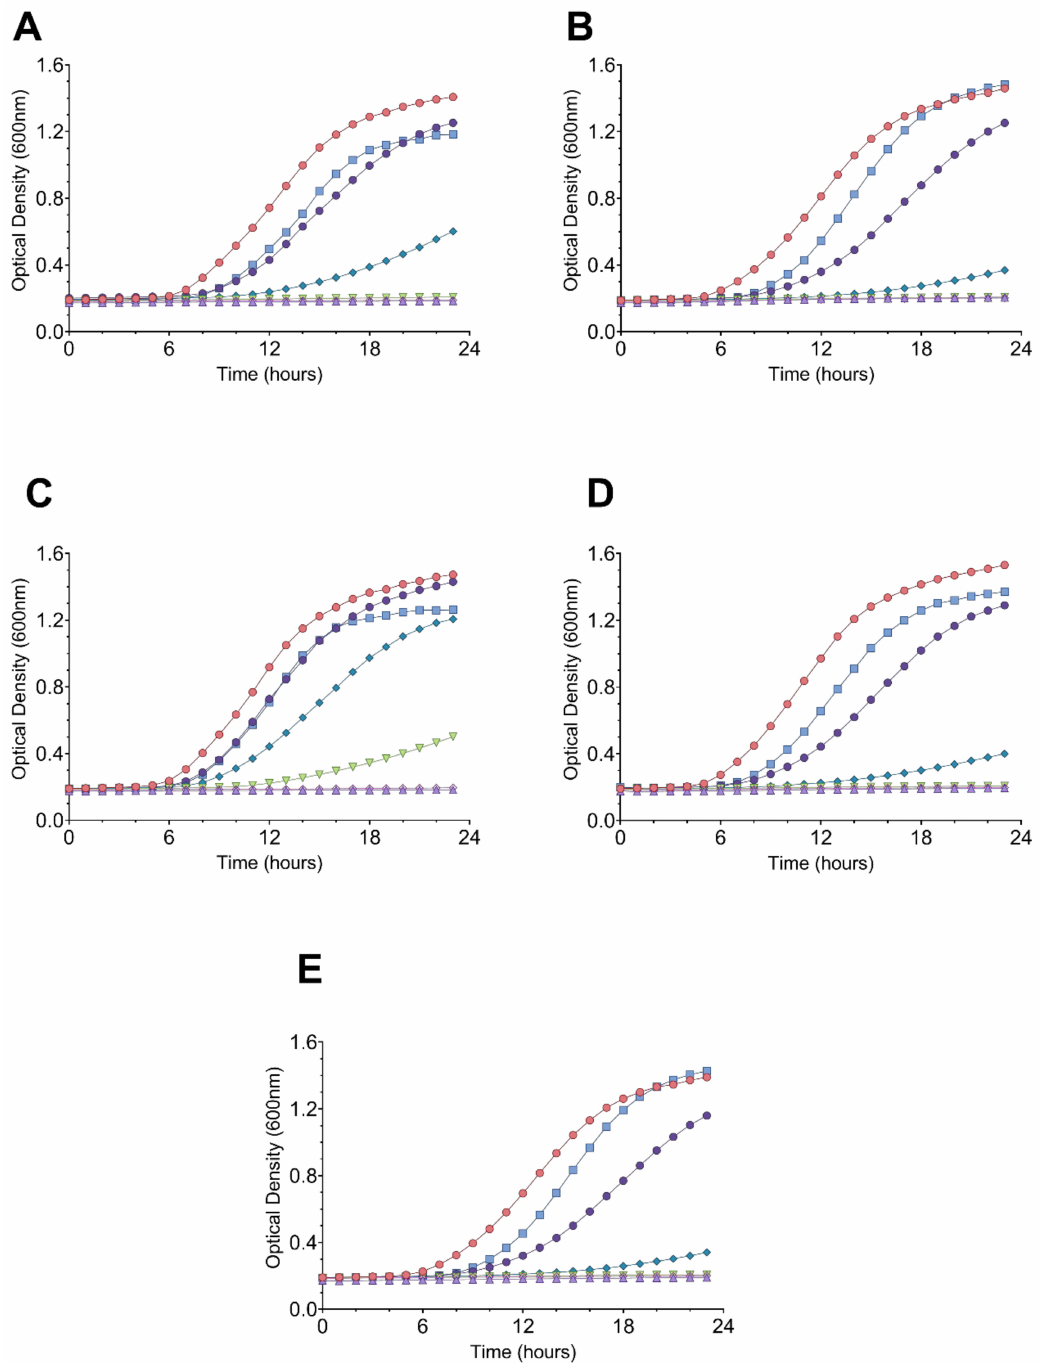
Figure 2. Dose-response growth inhibition of Salmonella Typhimurium ATCC 14028 by cell-free supernatants from strains UO.C025 ( A ), UO.C027 ( B ), UO.C031 ( C ), UO.C003 ( D ), and UO.C018 ( E ). Tested concentrations are 1 × (purple triangle), 1/2 (magenta diamond), 1/4 (triangle), 1/8 (diamond), 1/16 (dark purple circle), 1/32 (blue square), and 0 (negative control, red